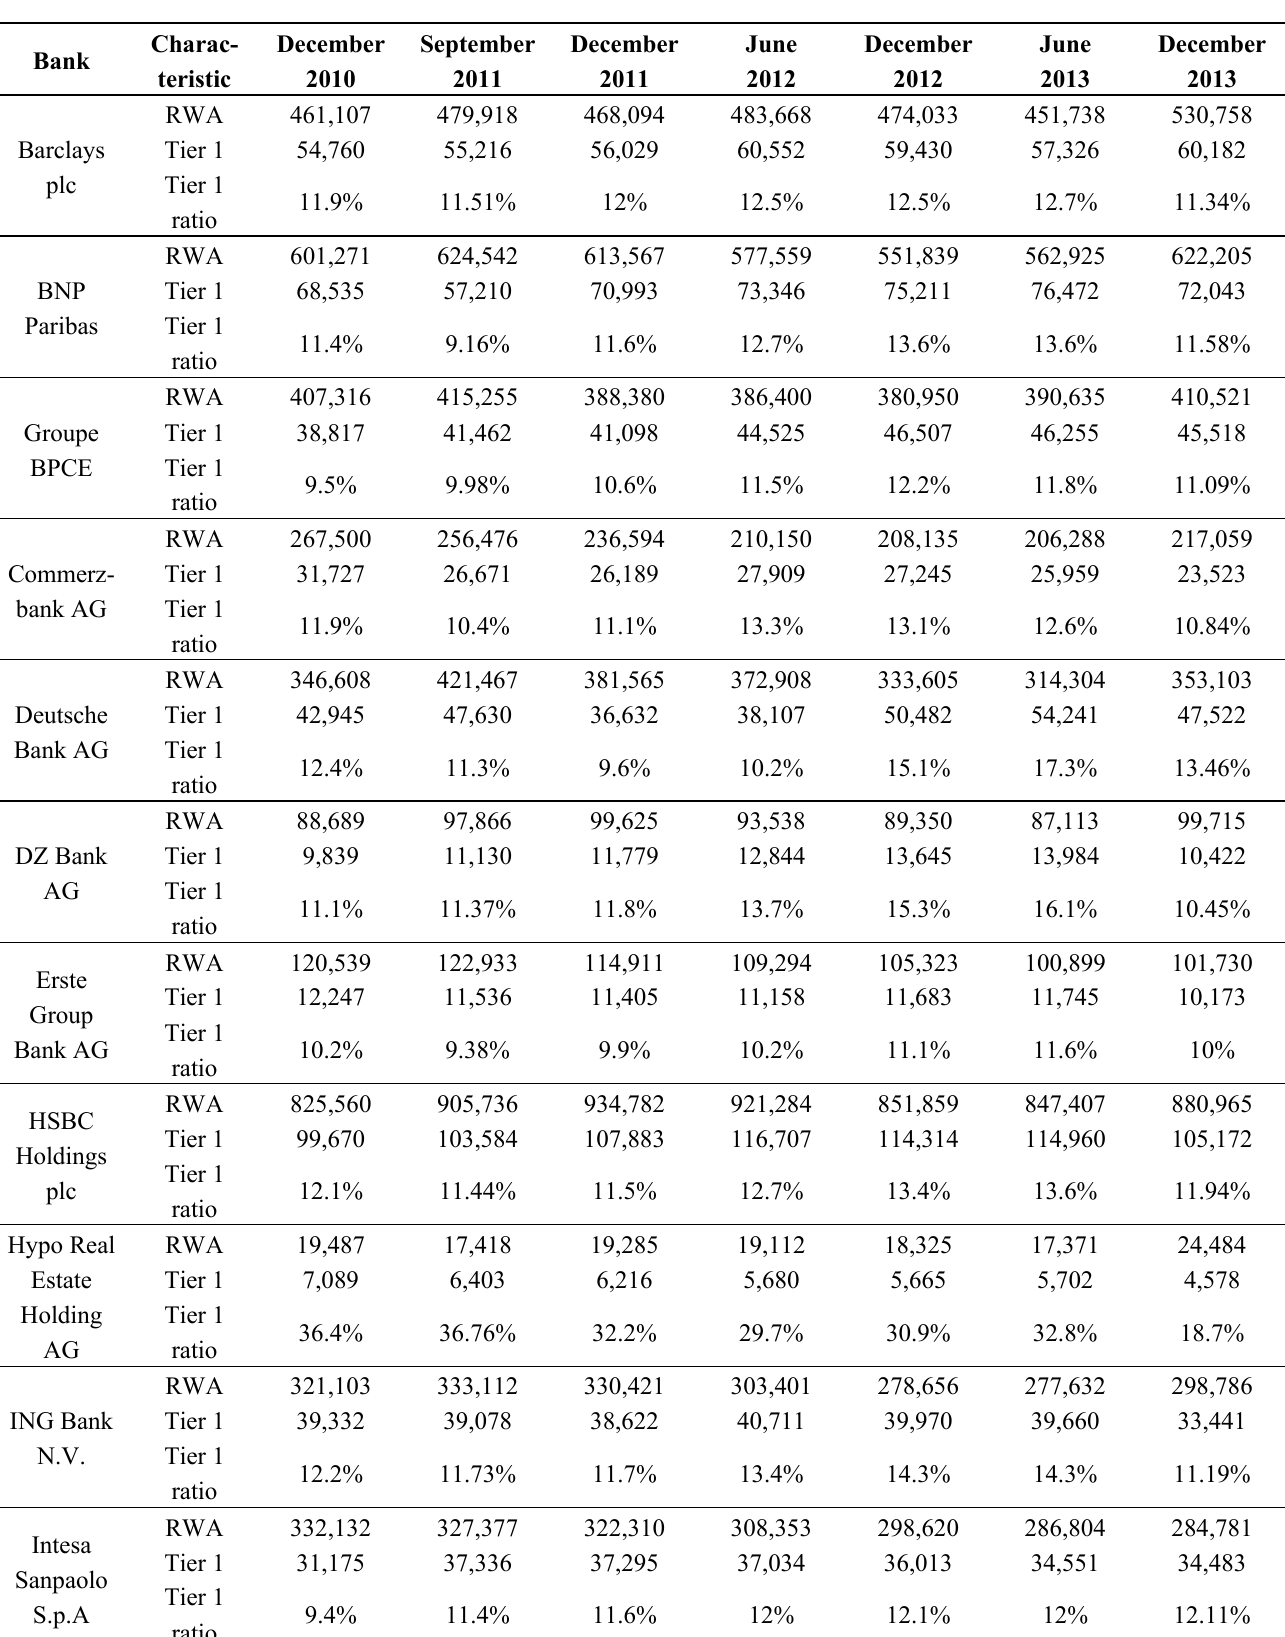
Table A2. Selected Balance Sheet Characteristics of Core